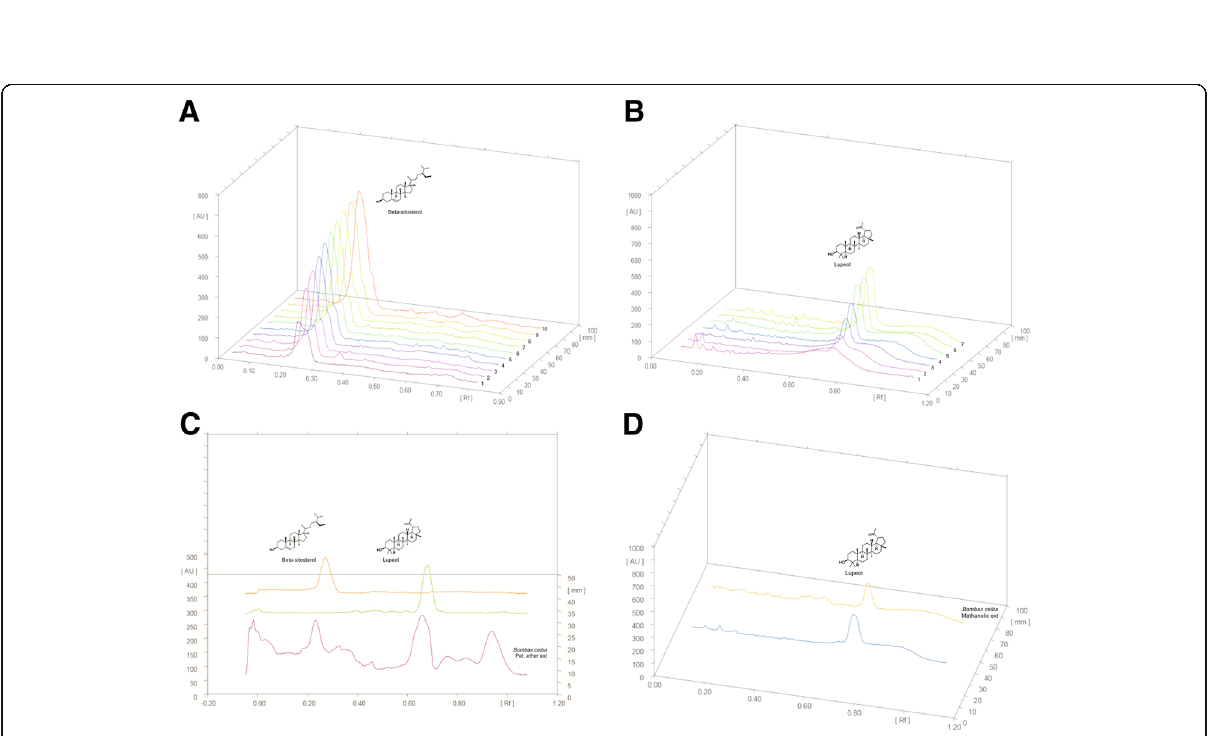
Fig. 2 HPTLC chromatograms: a Calibration curve for β -sitosterol; b Calibration curve for lupeol; c Quantification for β -sitosterol and lupeol in petroleum ether extract; and d Quantification of lupeol in methanolic extract of B. ceiba . Results: mean ± SD, analyzed by one-way ANOVA followed by Bonferroni ’ s multiple comparison tests; * P < 0.05 vs C (control); # P < 0.05 vs